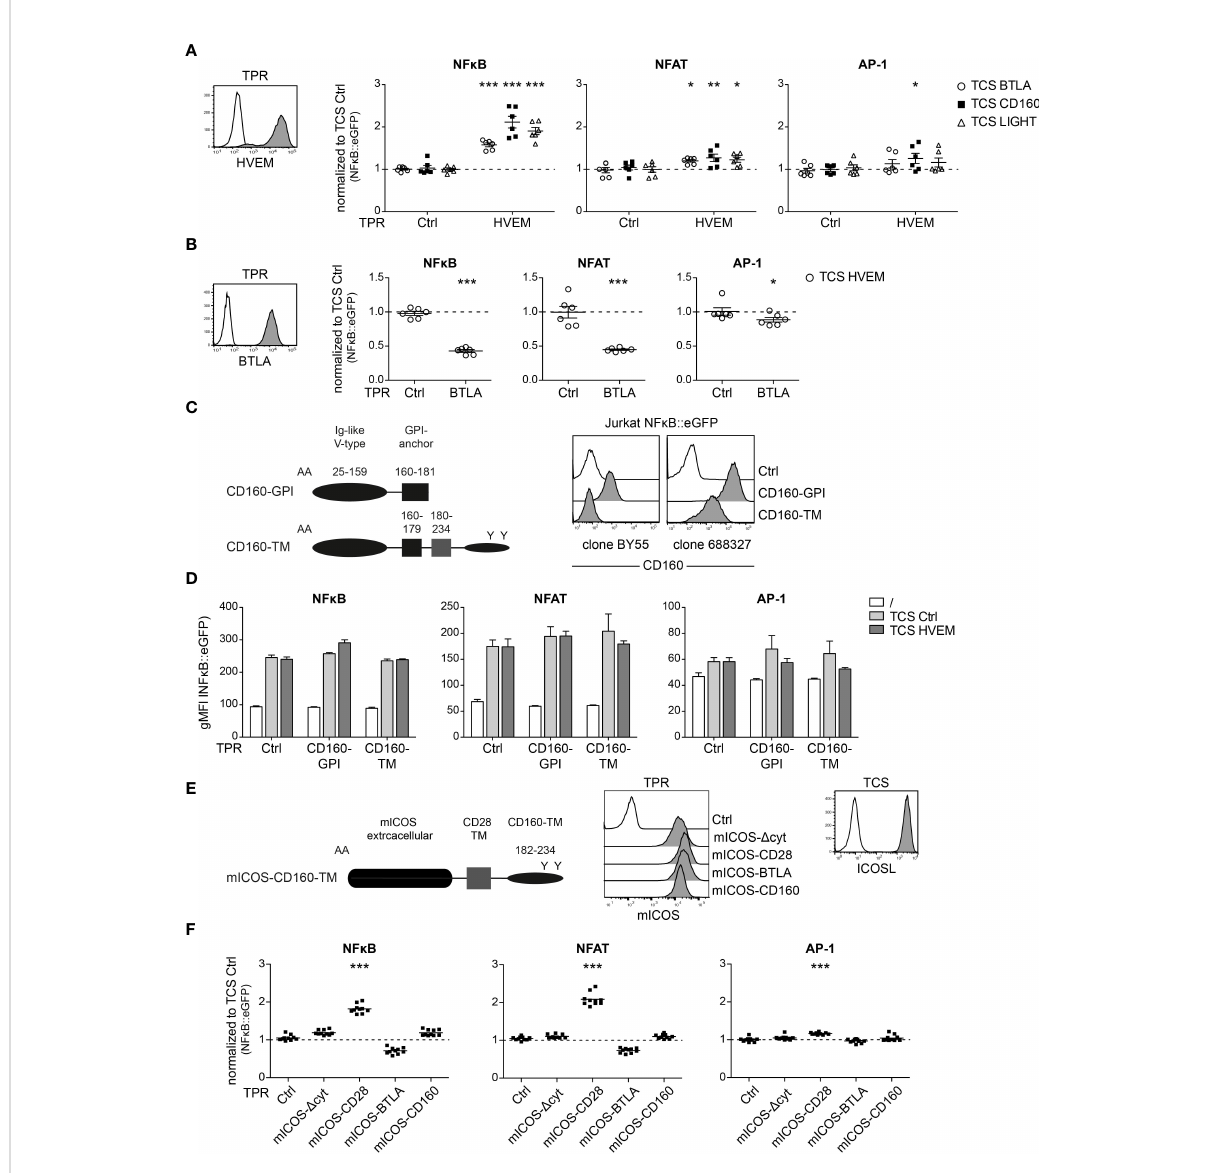
FIGURE 5 Evaluation of CD160 receptor function in a triple parameter reporter cell system. (A) Left panel: HVEM expressing triple parameter reporter cells (TPR; grey histogram) and control-TPR (open histogram) were analysed for HVEM expression. Right panel: Control TPR and TPR expressing HVEM were stimulated with TCS control or TCS expressing BTLA, CD160 or LIGHT. Reporter activation (NFAT::eGFP, NFkB::eCFP and AP-1::mCherry) was assessed via fl ow cytometry. Data of three independent experiments in duplicate is shown. Normalized reporter activation is shown (gMFI reporter gene expression induced by the indicated TCS/gMFI reporter gene expression induced by TCS ctrl stimulated cells). (B) Left panel: BTLA expressing triple parameter reporter cells (TPR; grey histogram) and control-TPR (open histogram) were analysed for BTLA expression. Right panel: Control TPR and TPR expressing BTLA were stimulated with control TCS and TCS HVEM. Results are shown from three independent performed experiments in duplicate. Normalized reporter activation is shown (gMFI of TCS HVEM of stimulated cells/gMFI of TCS ctrl stimulated cells). (A, B) For statistical evaluation, two-way ANOVA followed by Bonferroni ’ s test was performed (***p ≤ 0.001; **p ≤ 0.01; *p < 0.05). (C) Left panel: Schematic representation of two CD160 isoforms: the glycosylphosphatidylinositol-anchored-CD160 (CD160-GPI) and the transmembrane isoform of CD160 (CD160-TM). Right panel: Cell surface expression of CD160-GPI and CD160-TM on Jurkat TPR cells assessed by using two different antibodies (clone BY55 and clone 688327) (open histogram: control cells; grey histograms: expression of the indicated CD160 molecules). (D) Control TPR and TPR expressing the two isoforms CD160-GPI and CD160-TM, respectively, were left unstimulated or stimulated with the indicated TCS. (E) Left panel: Schematic representation of a mICOS-CD160-TM chimera. Middle panel: Expression of mICOS chimera on TPR. Right panel: TCS mICOSL (grey histogram) and control TCS (open histogram) were stained with a mICOSL antibody (F) mICOS-chimera expressing reporter cells were stimulated with TCS control and TCS mICOSL. Reporter gene expression induced by TCS mICOSL normalized to TCS control. For statistical evaluation, one-way ANOVA with Dunn ’ s multiple-comparisons test was performed (***p ≤ 0.001; **p ≤ 0.01; *p < 0.05). (A, B, D, F) ± D SD or mean is shown. Dotted line depicts control